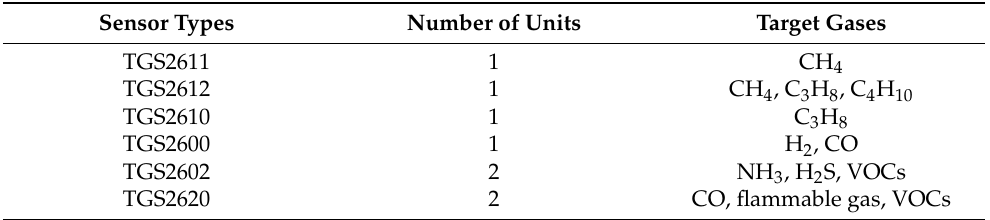
Table 3. Sample distribution in the dataset along with rate of chemical release (in sccm) and corre- sponding induced gas concentration level (in ppm) in the vicinity of the sensors. In total, 180 meas- urements were performed. The labels H, M, L, and n indicate high, medium, low, and zero concen- trations of the corresponding volatiles, respectively.